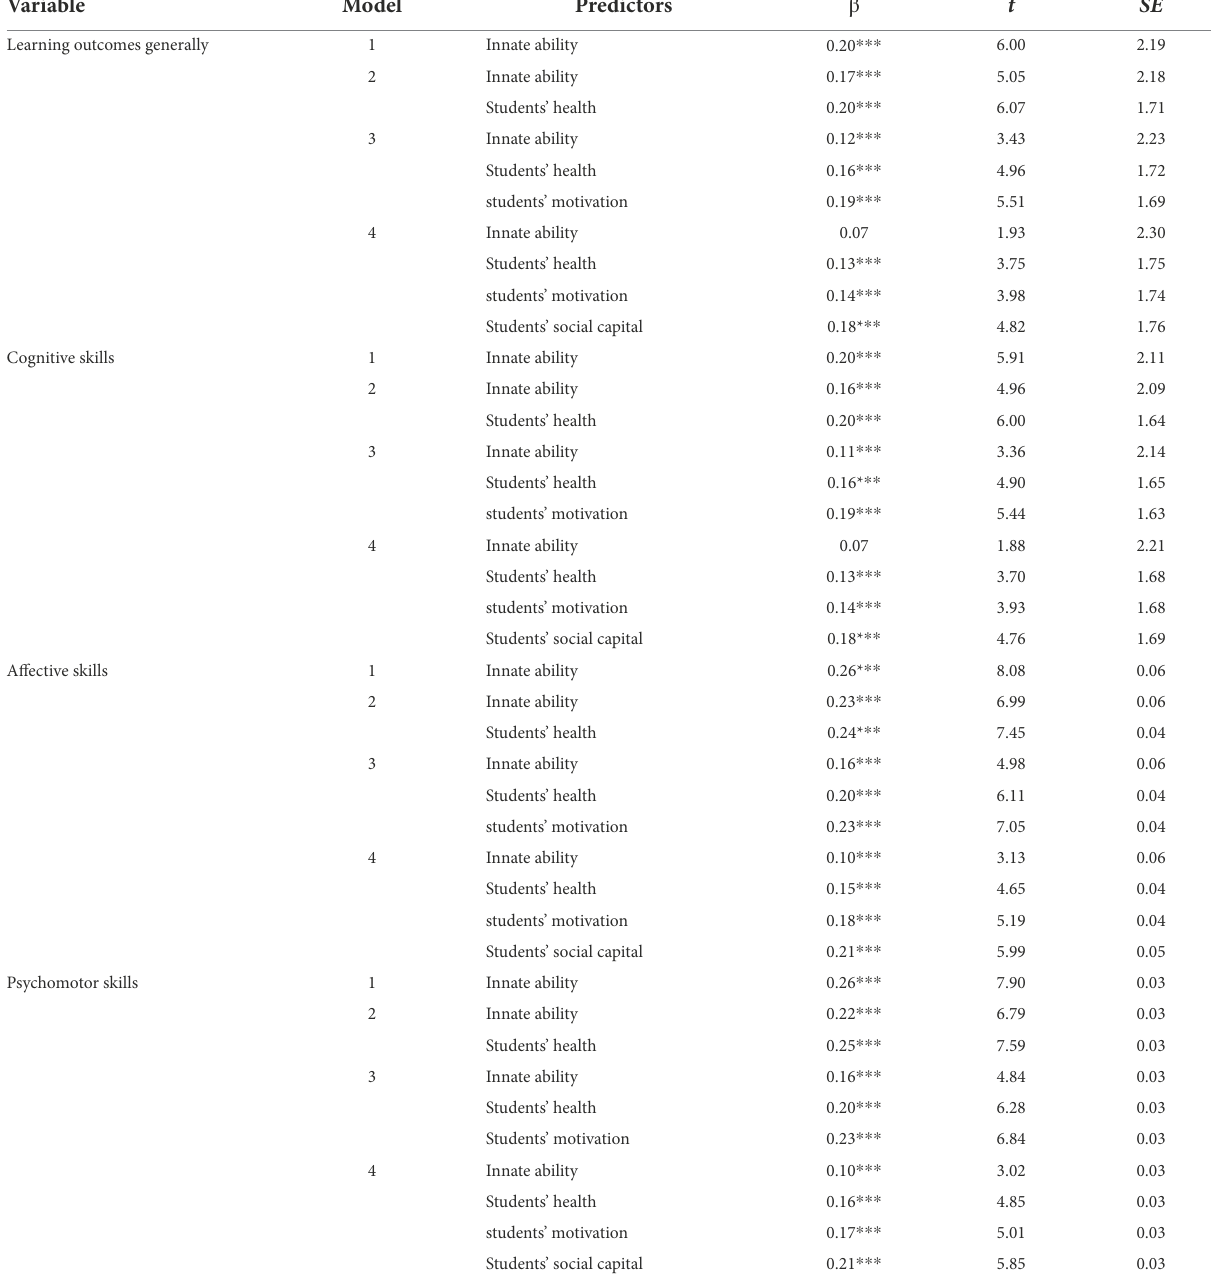
TABLE 4 Prediction of specific students’ inputs to learning outcomes generally and in terms of CAPs.